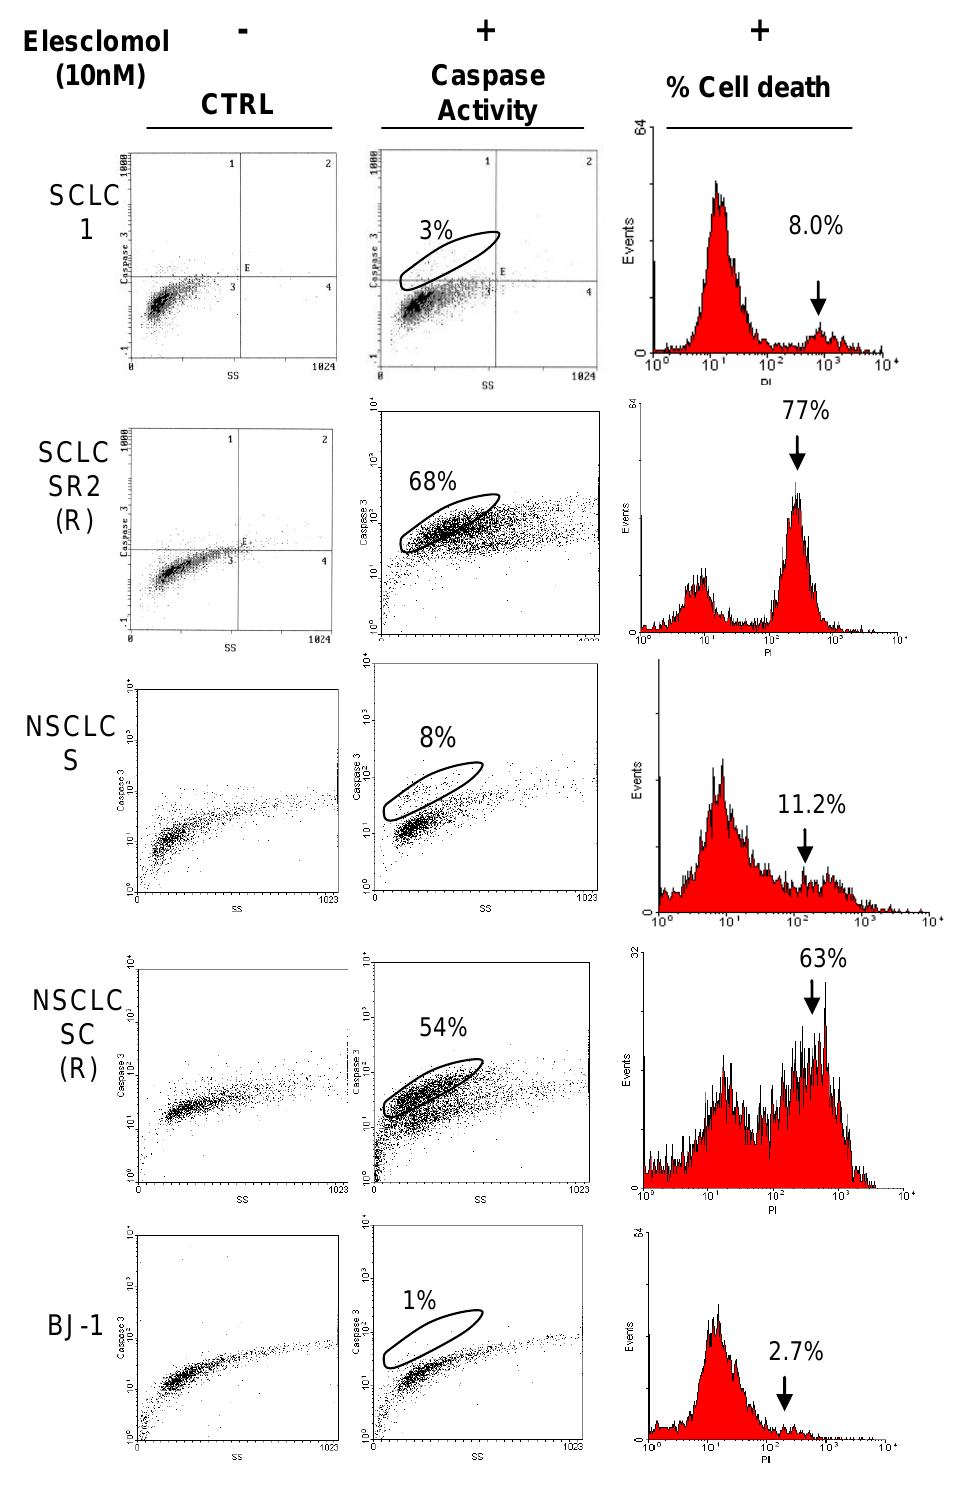
Figure 4. Elesclomol greatly stimulates caspase activity and cell death in cisplatin resistant cell line. Representative groups of SCLC and NSCLC were treated with 10 nM of elesclomol for 48 h and followed by caspase activity probe FMK-Fluoroscein. The percentage of caspase activation is correlated with percentage of cell death which was detected by PI staining. Elesclomol also has no effect against normal fibroblast BJ-1. Each dot plots and histograms are representative of two